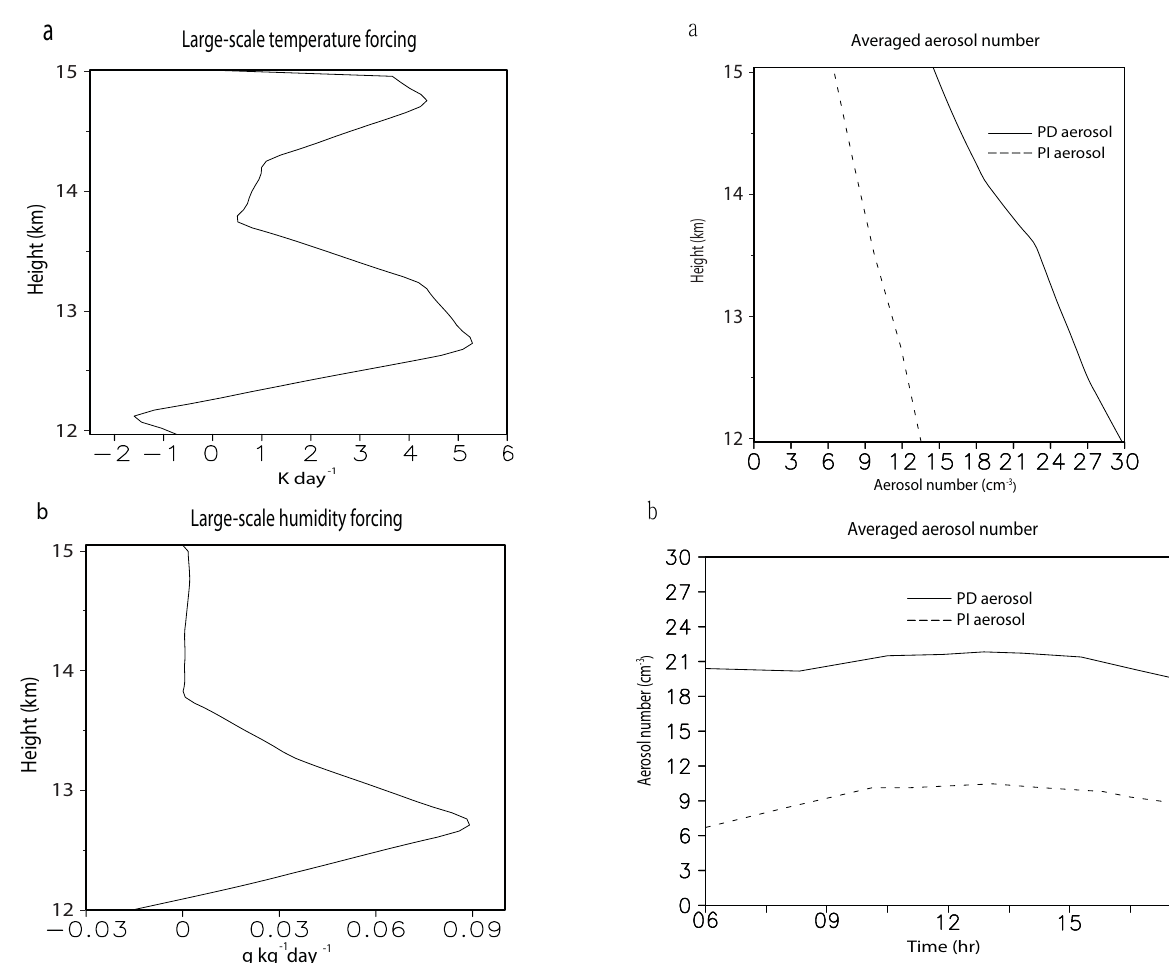
Fig. 2. Vertical distribution of the time- and area-averaged (a) po- tential temperature large-scale forcing and (b) humidity large-scale forcing.